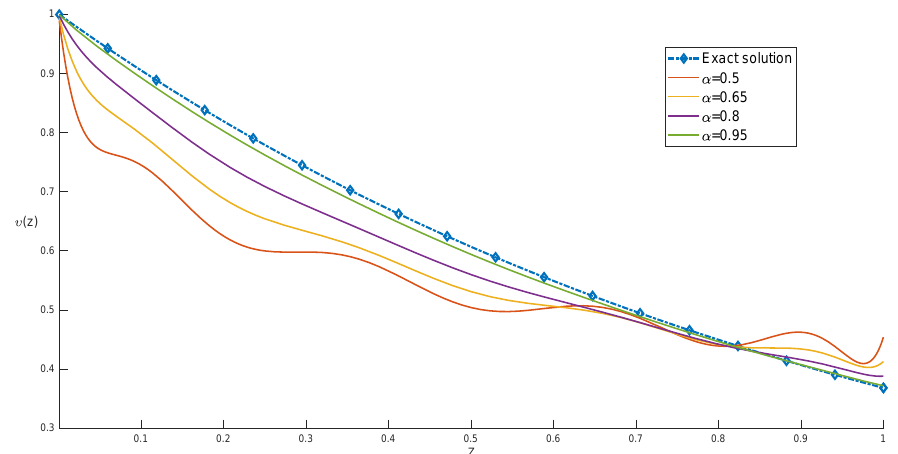
Figure 3. Exact and approximate solutions of Example 2 are compared at different scale